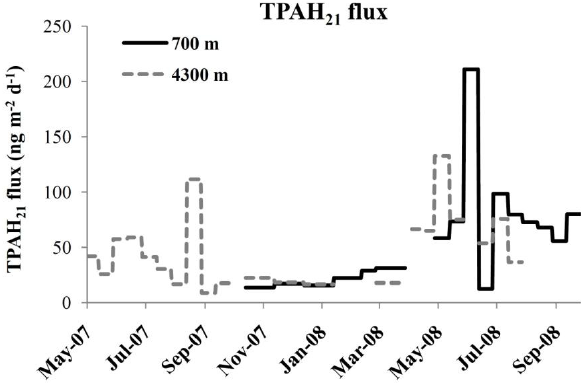
Figure 5. Temporal speciation of TPAH 21 flux at 700 m and 4300 m depth in the study area. Fig. 5. Time series of TPAH 21 flux at 700m and 4300m depth in the study